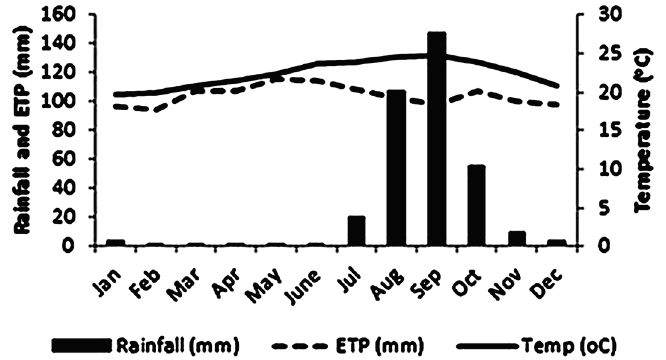
Figure 1. Location of the Ribeira Seca Watershed within Santiago Island and Cape Verde.